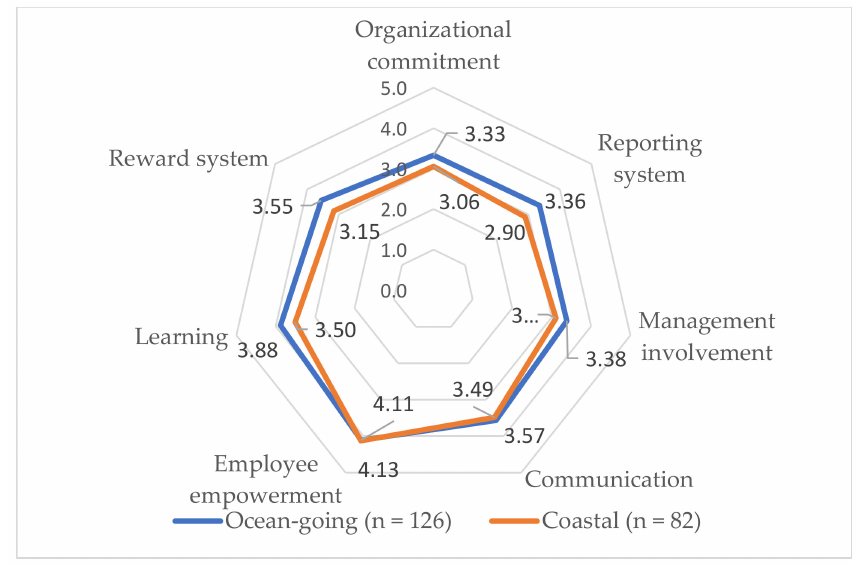
Figure 4. Comparisons of awareness on indicators of safety culture (Source: adopted from [8]). Figure 5 compares the differences in perceptions between groups by each indicator.